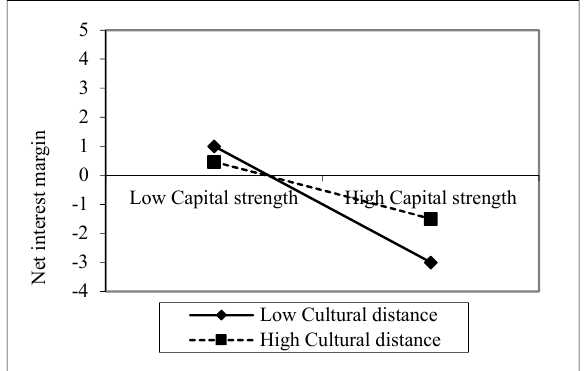
Figure 12. Capital Strength × Cultural Distance.